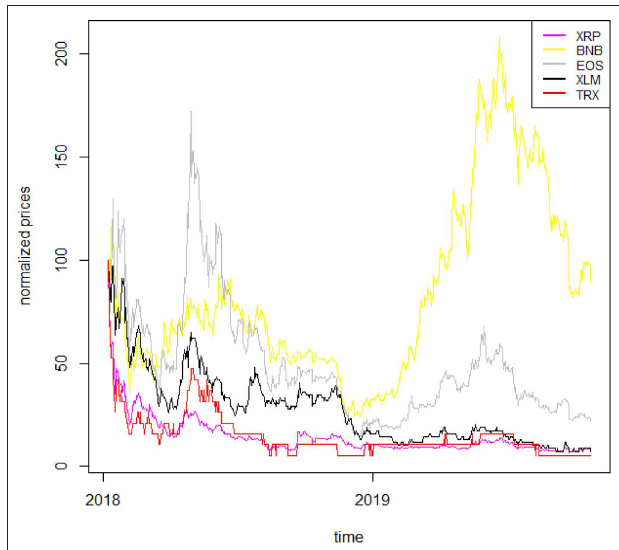
FIGURE 2 | Normalized cryptocurrency price series II. The figure shows the normalized price series for five cryptocurrencies: BTC, ETH,USDT, BCH, LTC, relative to the period 7 January 2018–17 October 2019.